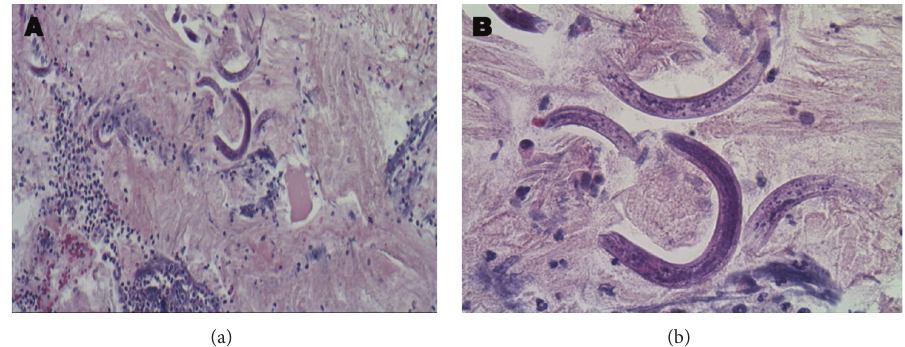
Figure 2: (a) and (b) Pathology shows bronchial epithelial cells, alveolar macrophages, and inflammatory cells but is negative for malignant cells. Filariform larvae, morphologically consistent with Strongyloides stercoralis , are present.